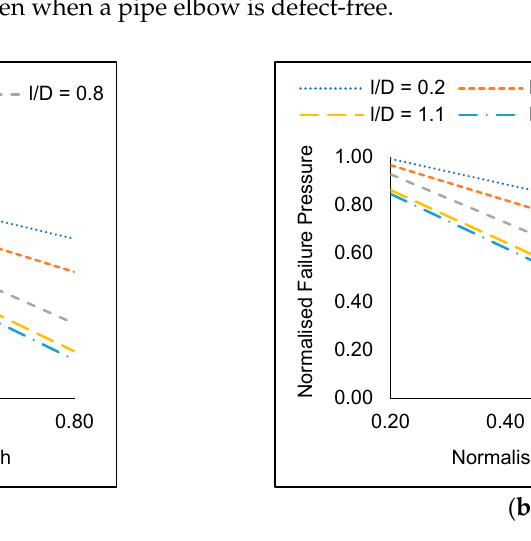
Figure 9. Normalised failure pressures of corroded API 5L X80 pipe elbow with a normalised defect length of 0.5 and subjected to a normalised axial compressive stress of 0.2 for a single defect located at the ( a ) intrados and ( b ) extrados.